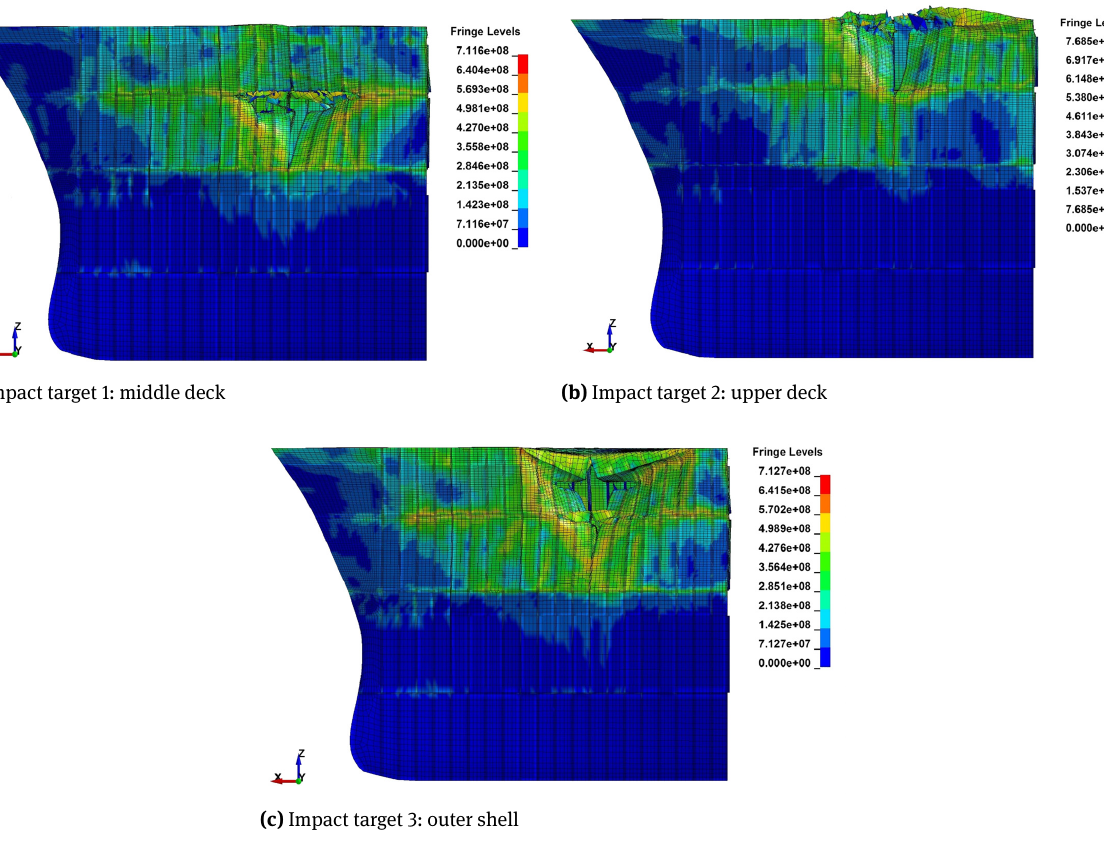
Figure 2: Structural conditions with v-m stress contours after three targets are given impact loading